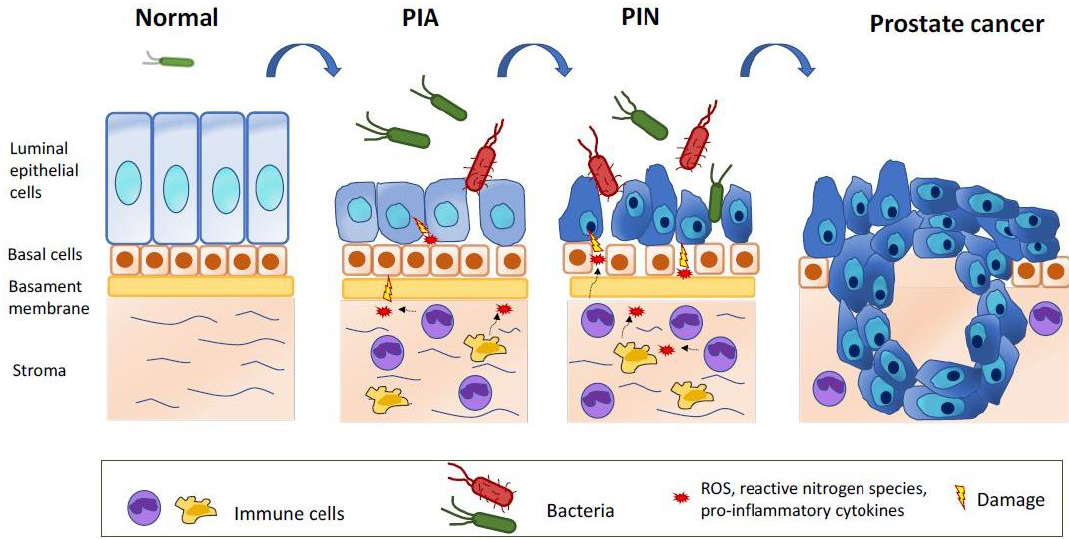
Figure 1 . Inflammation and prostate cancer development stages: the healthy prostate contains in the prostatic fluid antimicrobial peptides and no or very few commensal microorganisms, which are not pathological when the integrity of luminal epithelial barrier is maintained.